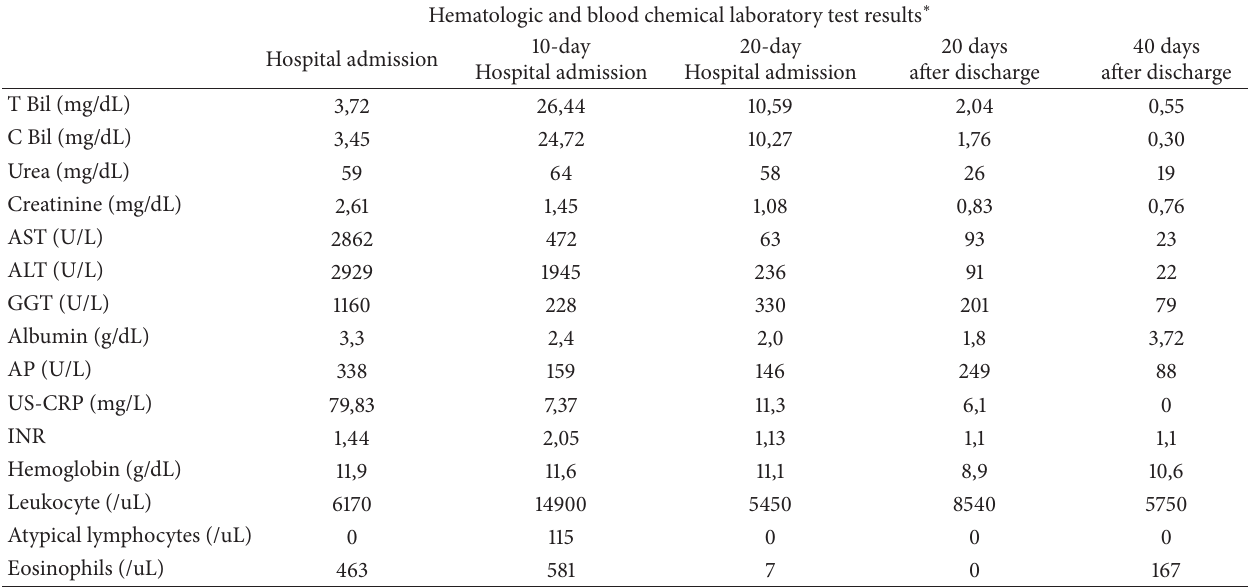
Table 1: Evolution of laboratory test results during hospitalization.